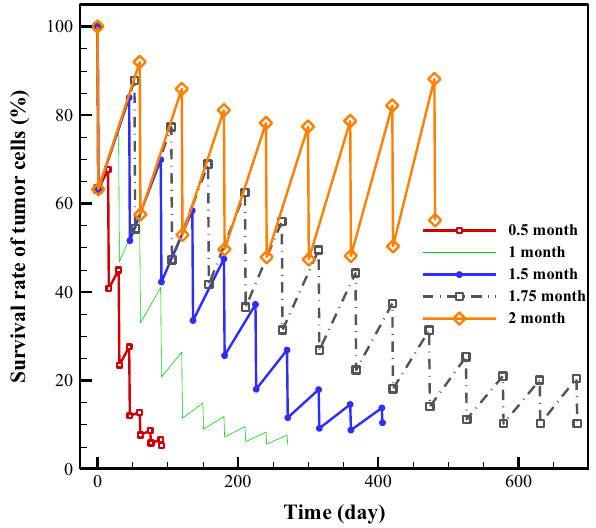
Figure 2. Survival rate of tumor cells for different times between successive treatments. Assuming the same injected dose ( C p ), the responses of TCs under five treatment plans with variable timing, including 0.5-month, 1-month, 1.5-month, 1.75-month, and 2-month, are examined here. Red, green, blue, gray, and orange colors are demonstrated the results for break timings of 0.5-month, 1-month, 1.5-month, 1.75-month, and 2-month,